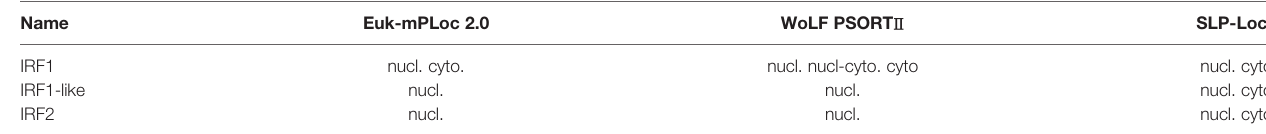
TABLE 3 | Summary of the predicted subcellular localization of CfIRF1, CfIRF1-like and CfIRF2 .